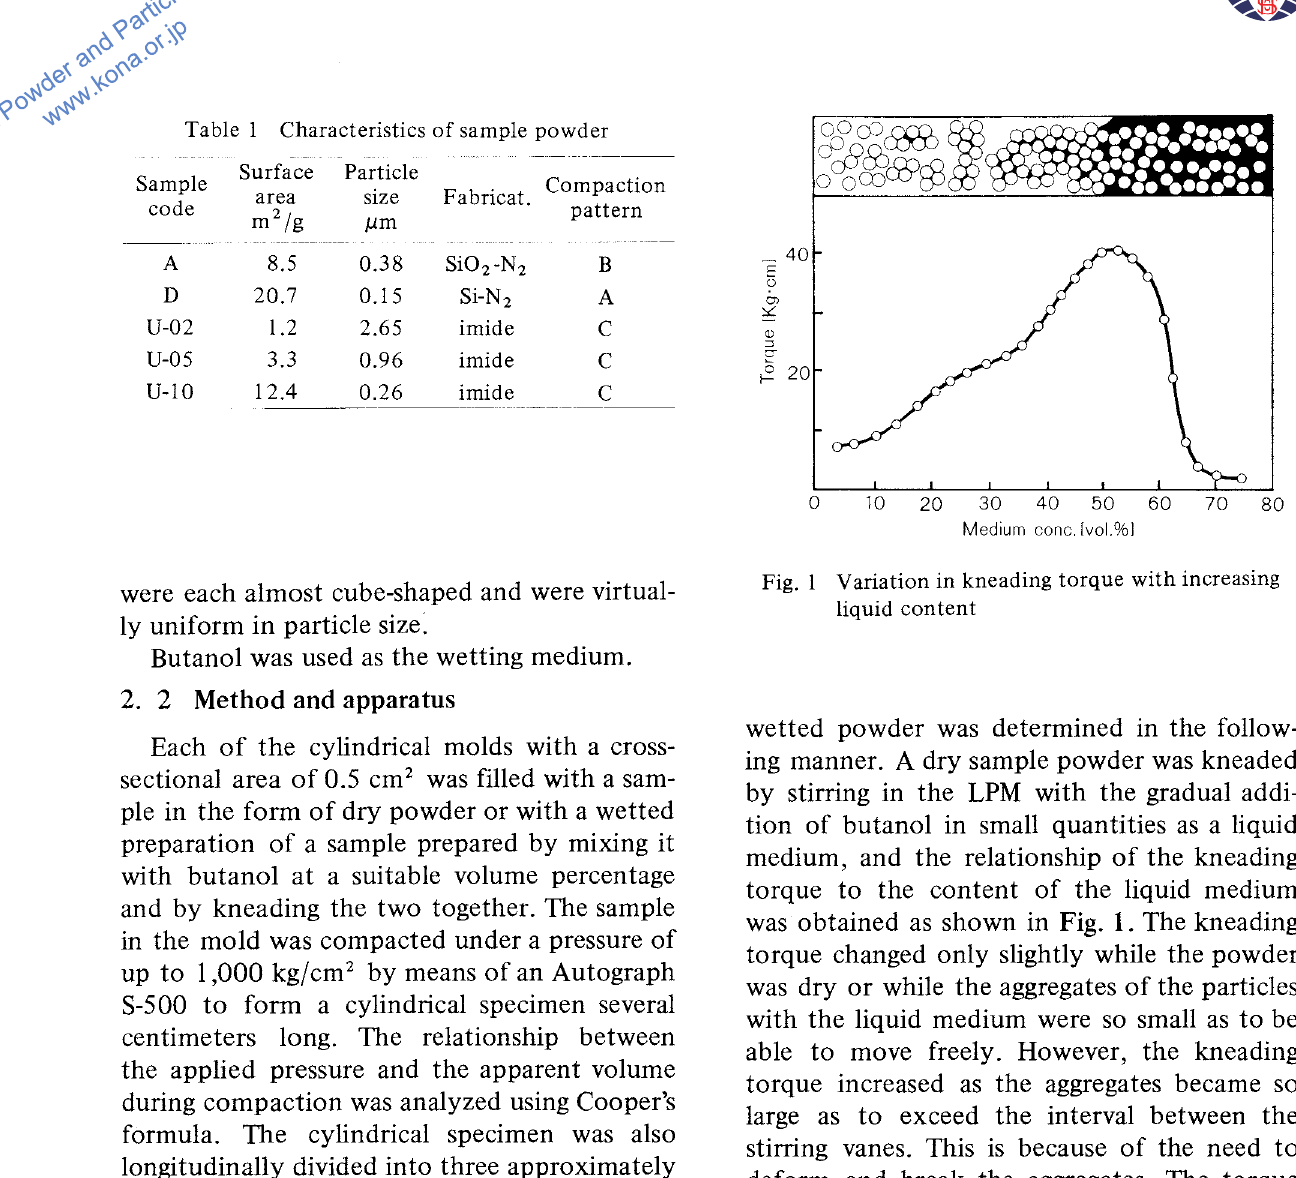
Table 1 Characteristics of sample powder